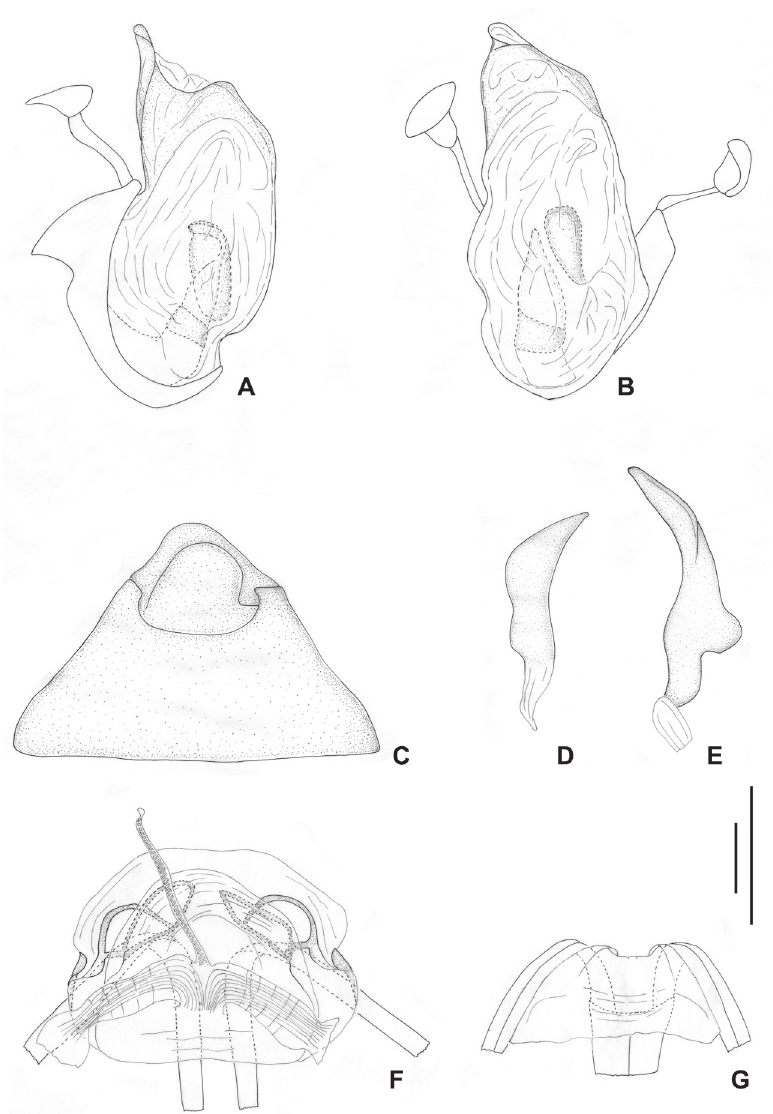
Fig. 9. Genitalia of C. parvum sp. nov. A . Aedeagus, left lateral view. B . Aedeagus, ventral view. C . Genital capsule. D . Right paramere. E . Left paramere. F . Dorsal labiate plate of bursa copulatrix. G . Posterior wall of bursa copulatrix. Scale bars = 0.1 mm (the large scale bar is for A–B and D–E, the small scale bar is for C and